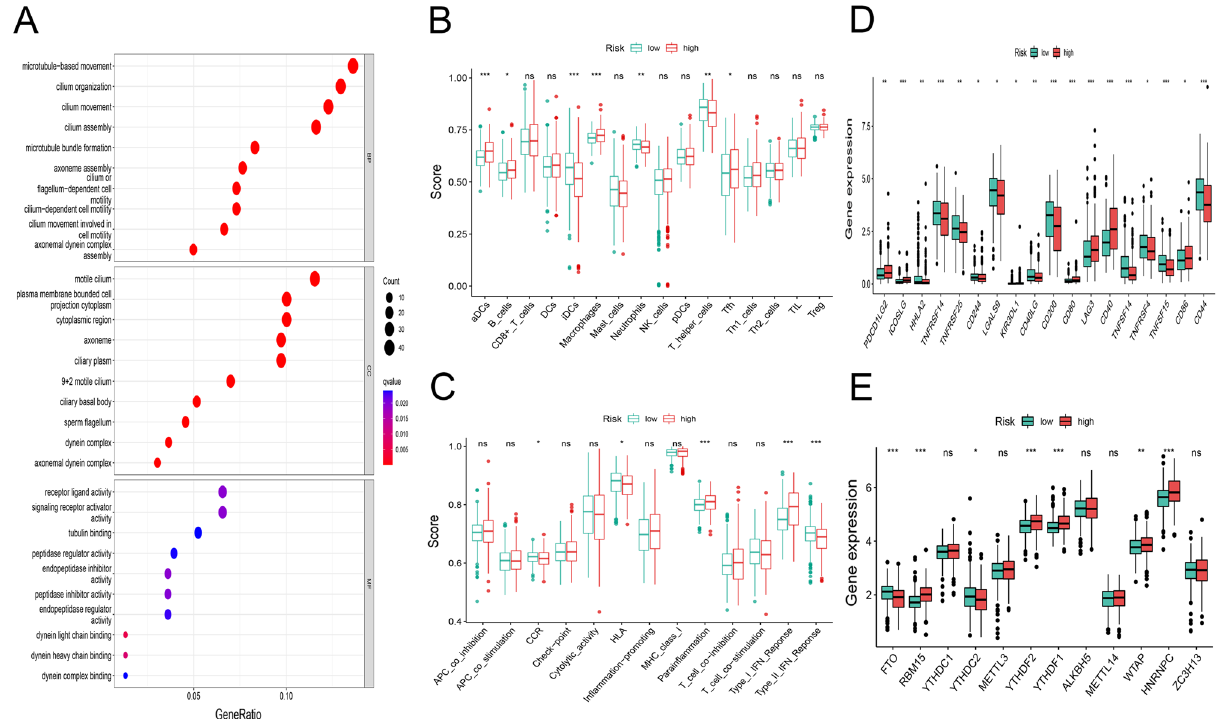
Figure 6. Functional enrichment analysis and immune infiltration levels of differential genes in the two risk subgroups. ( A ) GO analysis of differentially expressed genes. ( B ) Infiltration levels of immune cells. ( C ) Infiltration scores of immune pathways. Differential expression of 18 common immune checkpoints ( D ) and 12 M6A-related genes ( E ) between the two risk